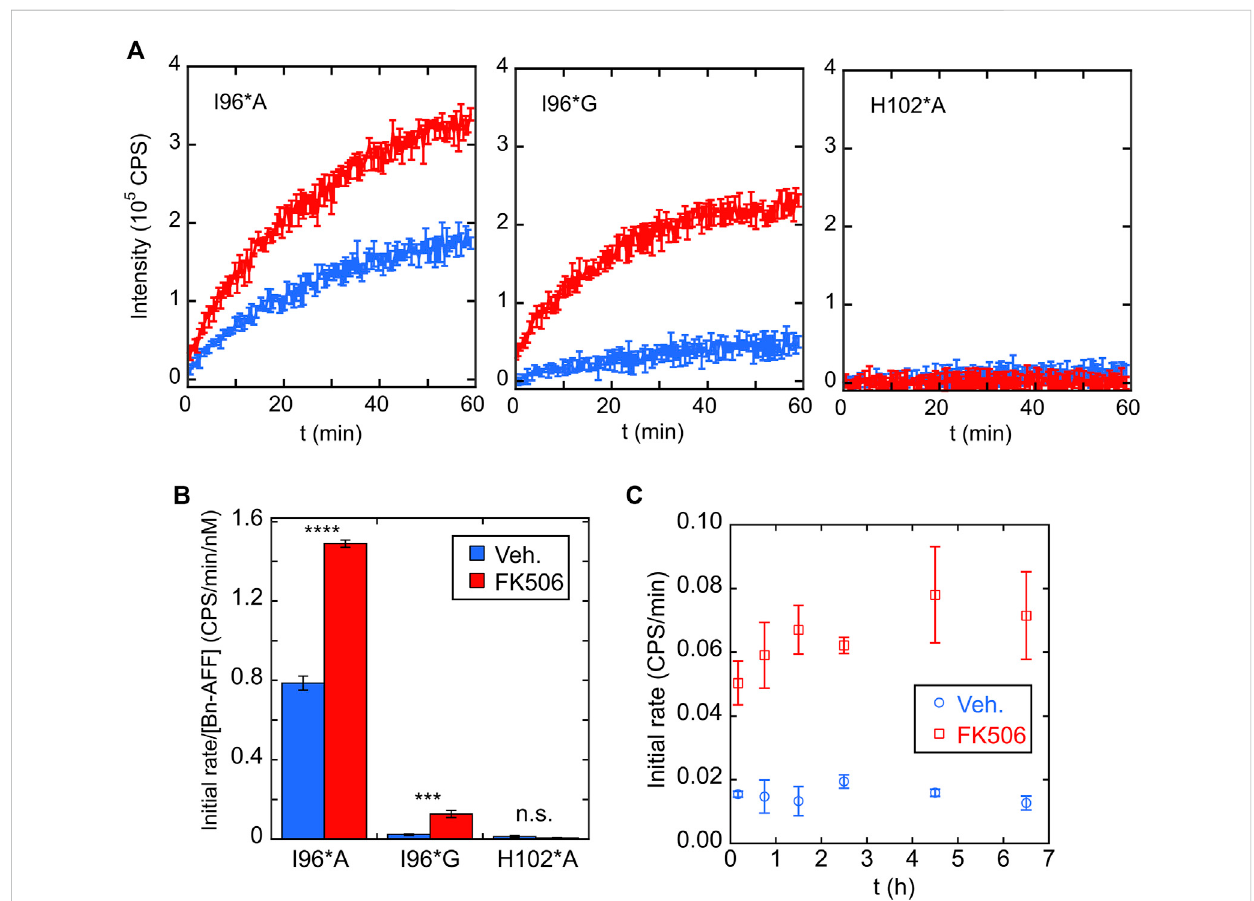
FIGURE 5 Bn-AFF shows ligand-dependentactivation in vitro. (A) RNAhydrolysis intheabsence ofFK506 (blue curves) indicatedthat I96*G Bn-AFF had lower baselineenzymaticactivitycomparedtoI96*A,consistentwithahigher ΔΔ G N/CP valueforI96*G.AdditionofFK506(redcurves)enhancedRNAhydrolysis by I96*A and I96*G. No signi fi cant RNA hydrolysis was observed for the control H102*A protein either in the absence or presence of FK506. (B) Quanti fi cation of FK506-dependent turn-on found 1.9 ± 0.1-fold and 5.3 ± 1.5-fold increases for I96*A and I96*G variants of Bn-AFF. Signi fi cance was evaluated using a t -test with unequal variance; *** p < 10 − 3 ; **** p < 10 − 4 ; n.s., not signi fi cant. (C) FK506 triggered the increase in enzymatic activity of I96*G variant mostly within the dead time of mixing, estimated to be ~10 min. Data are represented as mean ± s.d., of three technical